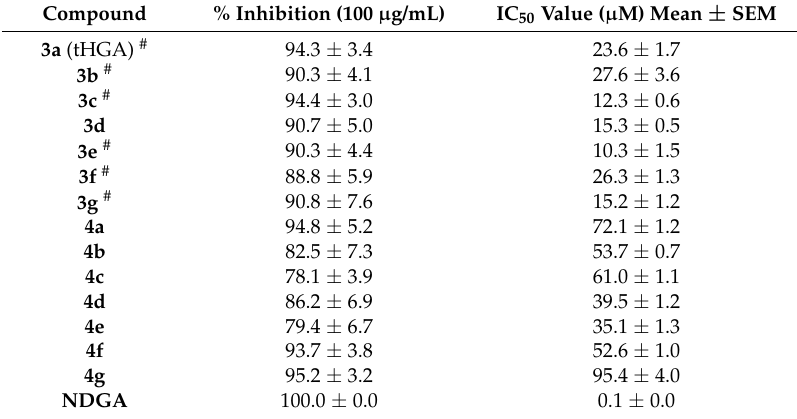
Table 1. IC 50 values and % inhibition for the inhibition of soybean lipoxygenase (LOX)-1 by the tested compounds. NDGA, nordihydroguaiaretic